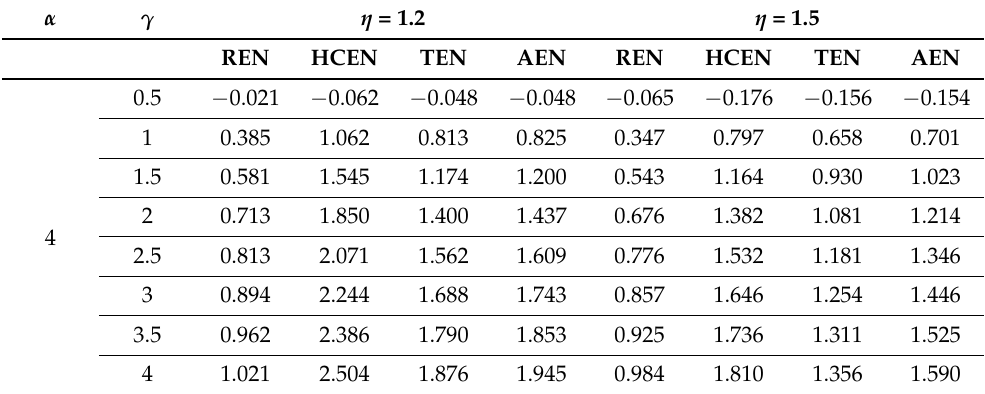
Table 2. Analysis of the REN, HCEN, TEN, and AEN for the HL-INH distribution at λ = 1.5 and η = 1.2 and